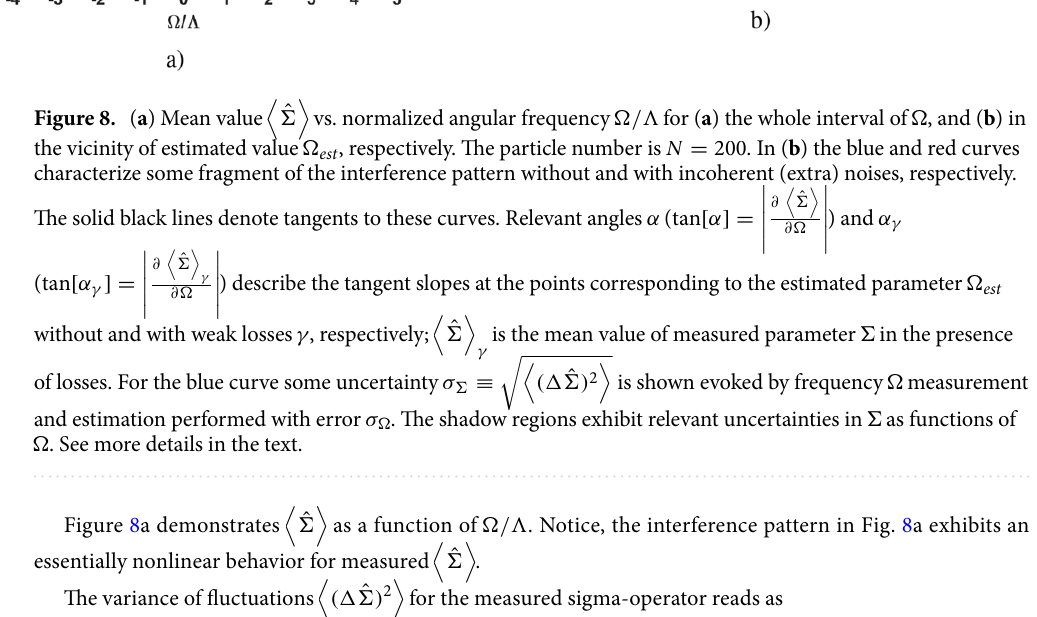
for the measured sigma-operator reads as